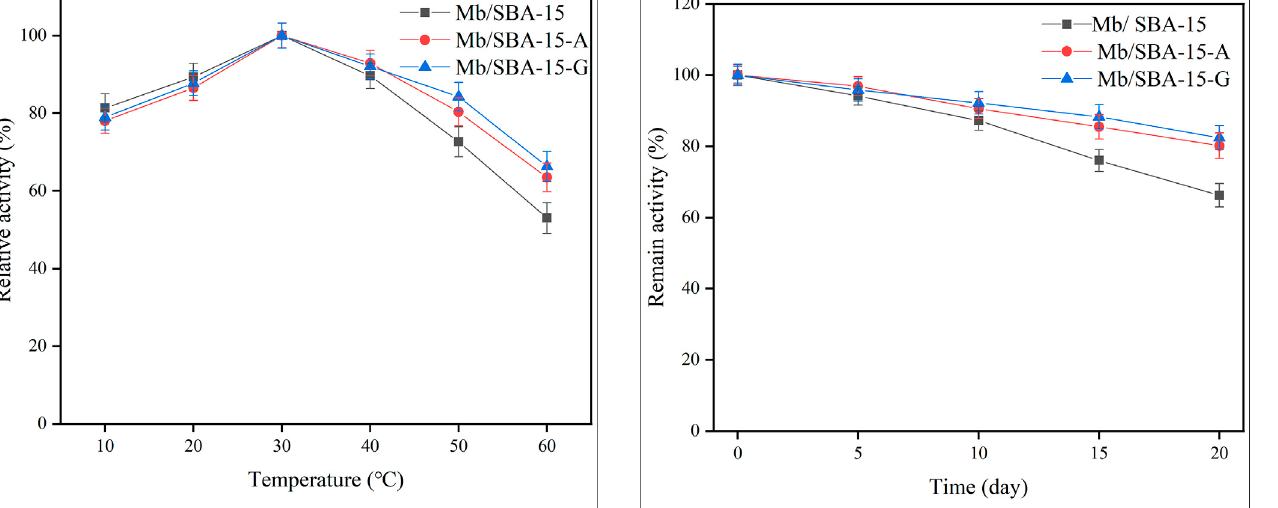
FIGURE 3 | The temperature stability of immobilization Mb. FIGURE 4 | The effect of storage time on the remain